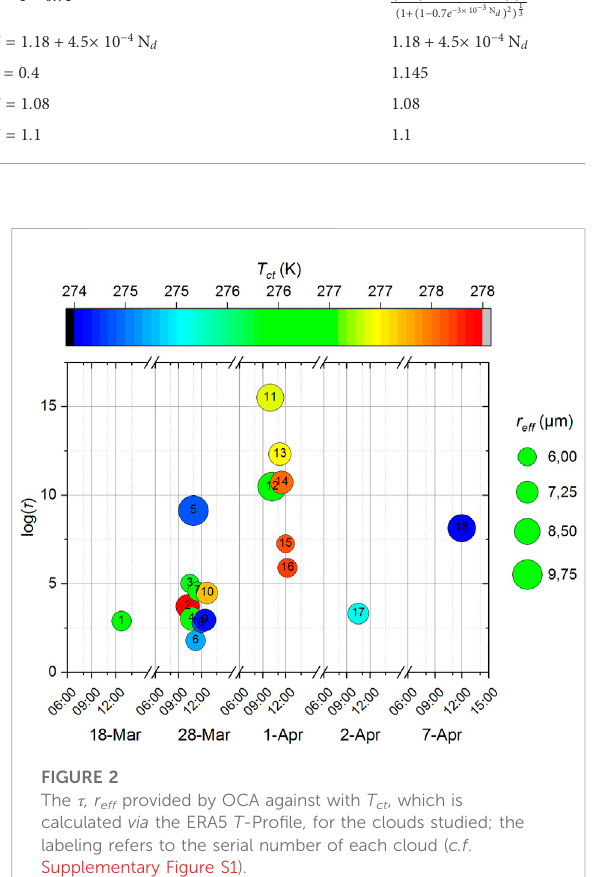
FIGURE 2 The τ , r eff provided by OCA against with T ct , which is calculated via the ERA5 T -Pro fi le, for the clouds studied; the labeling refers to the serial number of each cloud ( c.f . Supplementary Figure S1).